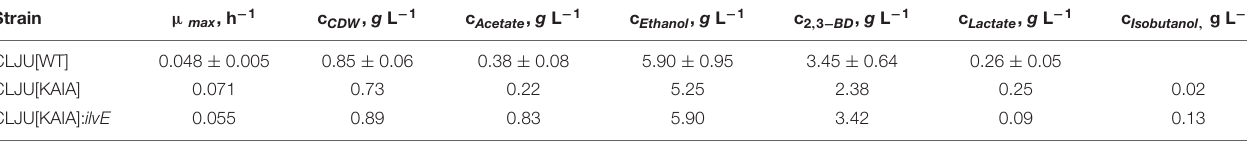
Rates reflect exponential growth. Values of the wildtype cultivation indicate mean of duplicates. TABLE 2 | Final biomass and product yields of the syngas-based batch cultivations of the different C. ljungdahlii strains in steadily gassed stirred-tank bioreactor ( T = 37 ◦ C; pH = 5.9; V R = 3 L; 500 rpm). Strain Y CDW Y Acetate Y Ethanol Y 2 , 3 − BD Y Lactate Y Isobutanol C-mole ( Product ) mole − 1 ( CO )